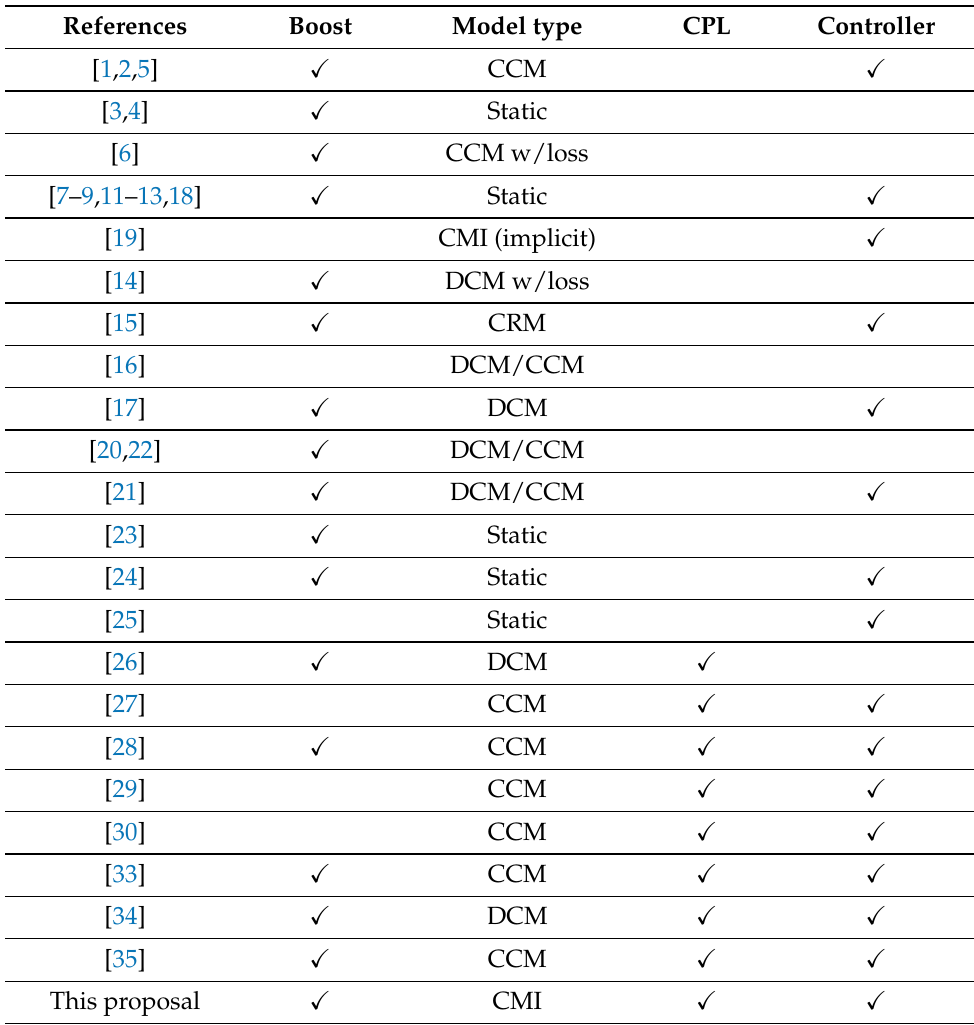
Table 1. Summary of the literature